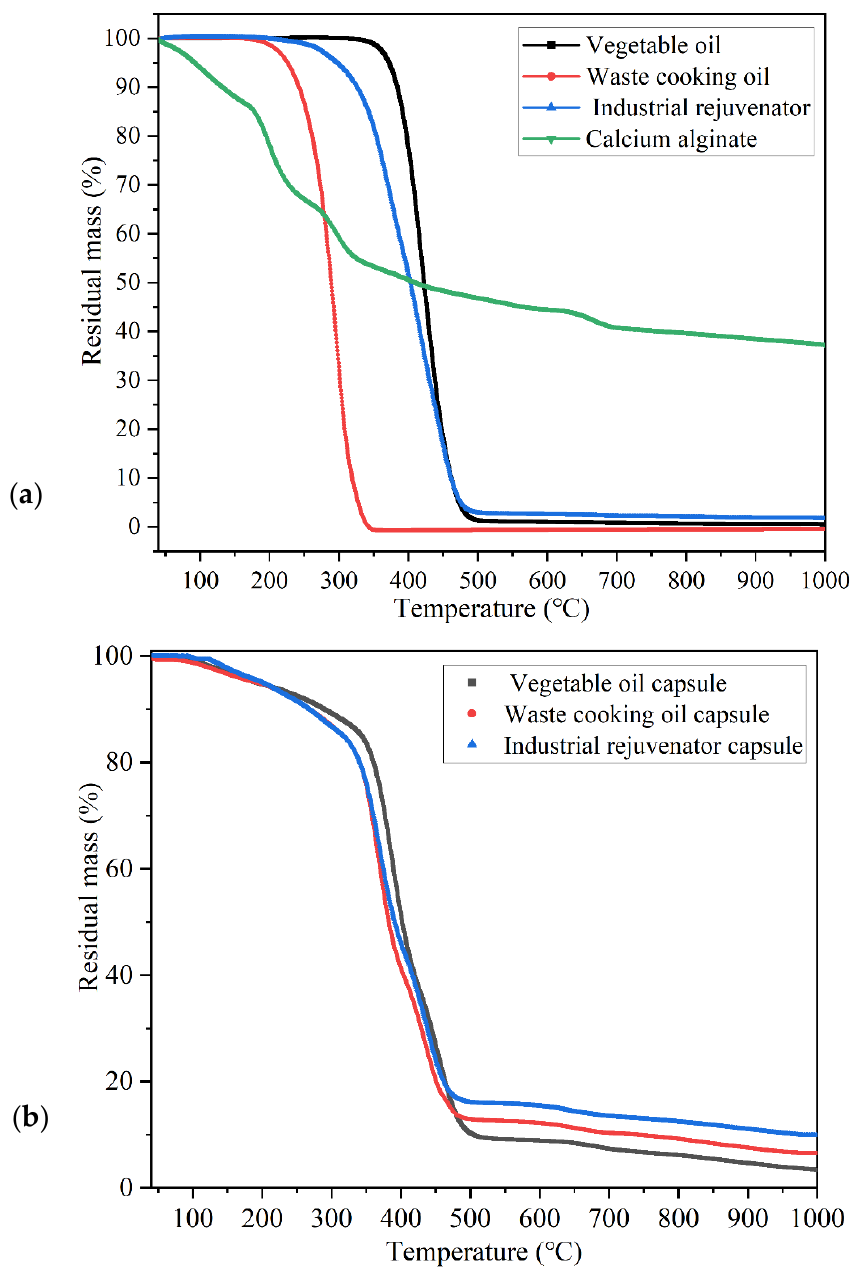
Figure 6. The mass loss curves of ( a ) raw materials and ( b ) capsules containing different healing agent.